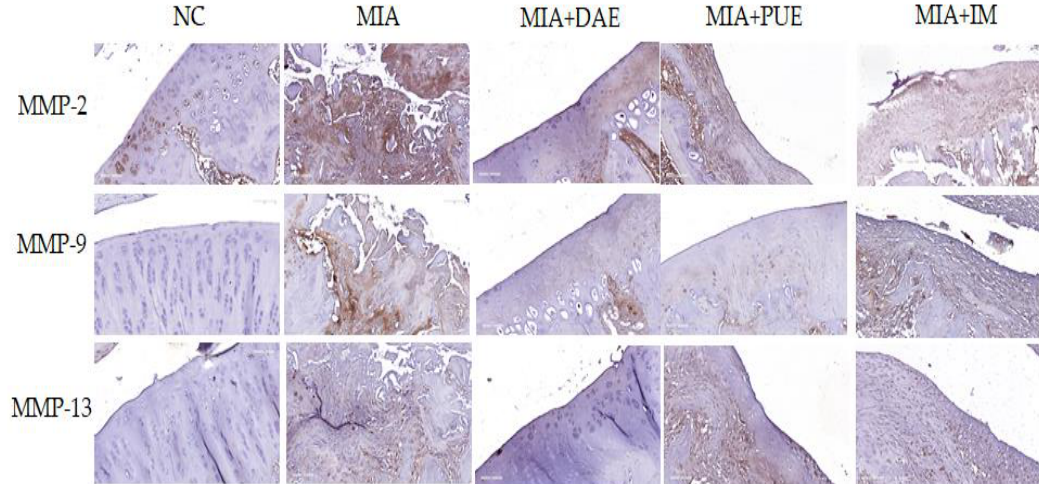
Figure 5. Effects of DAE and PUE on the expression of MMP-2, MMP-9, and MMP-13 in knee joint tissues of MIA-induced OA rats. Representative images of immunohistochemical staining of MMP-2, MMP-9, and MMP-13 expression in knee joint tissues. NC, untreated; MIA, only MIA-induced; MIA + DAE, MIA-induced and DAE-treated; MIA + PUE, MIA-induced and PUE-treated; MIA + IM, MIA-induced and IM-treated rats.